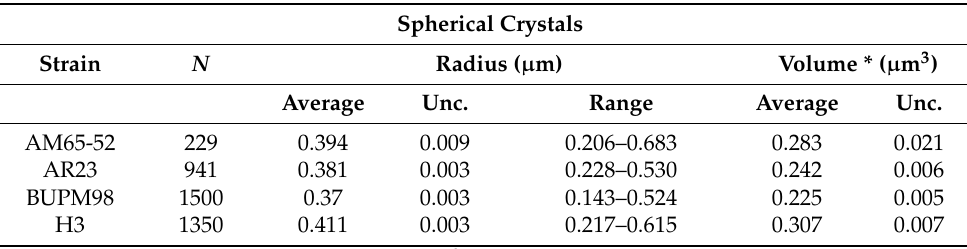
Table 3. Morphological data of crystals of the three B. thuringiensis var. israelensis and B. thuringiensis H3 spherical crystals for N